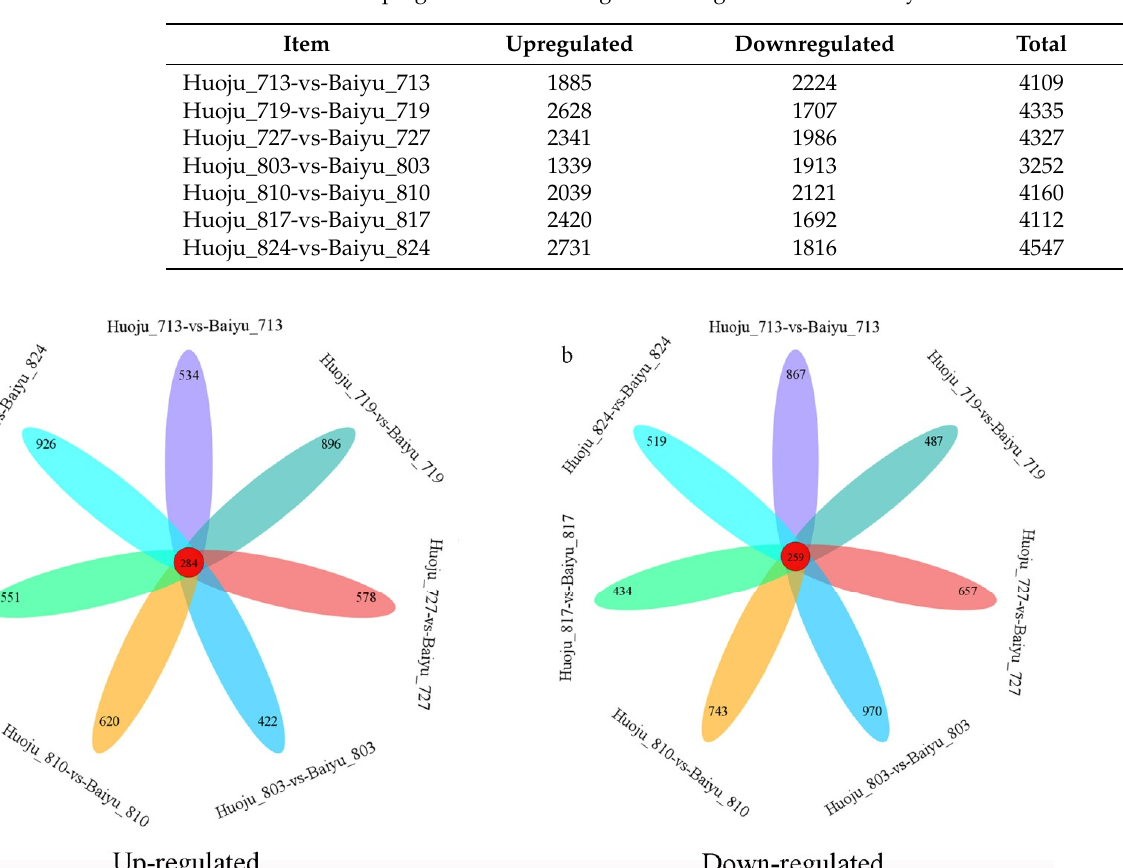
Table 4. Statistics of upregulated or downregulated unigenes in each library.